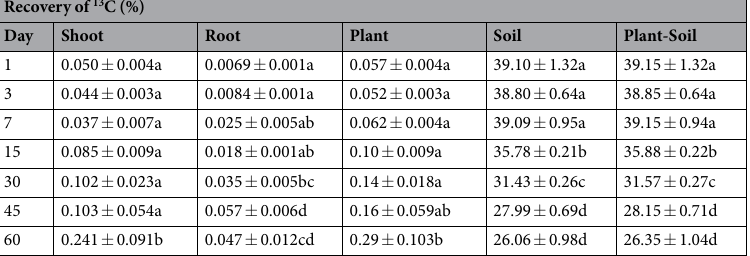
Table 2. Recovery of γ -PGA- 13 C in the carbon (C) pools of plant-soil system at different sampling days. Means followed by the different letters in the same column are significantly different (p = 0.05). Plant 13 C recovery was calculated as the sum of 13 C recovery in shoot and root, 13 C recovery of plant-soil was calculated as the sum of the 13 C recovery in plant and soil.